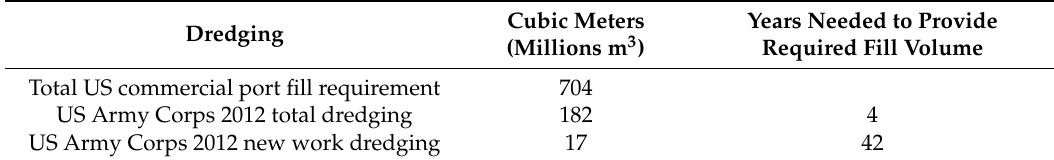
Table 11. Amount of fill necessary to elevate 100 US commercial ports compared to US Army Corps 2012 dredging quantities [41].